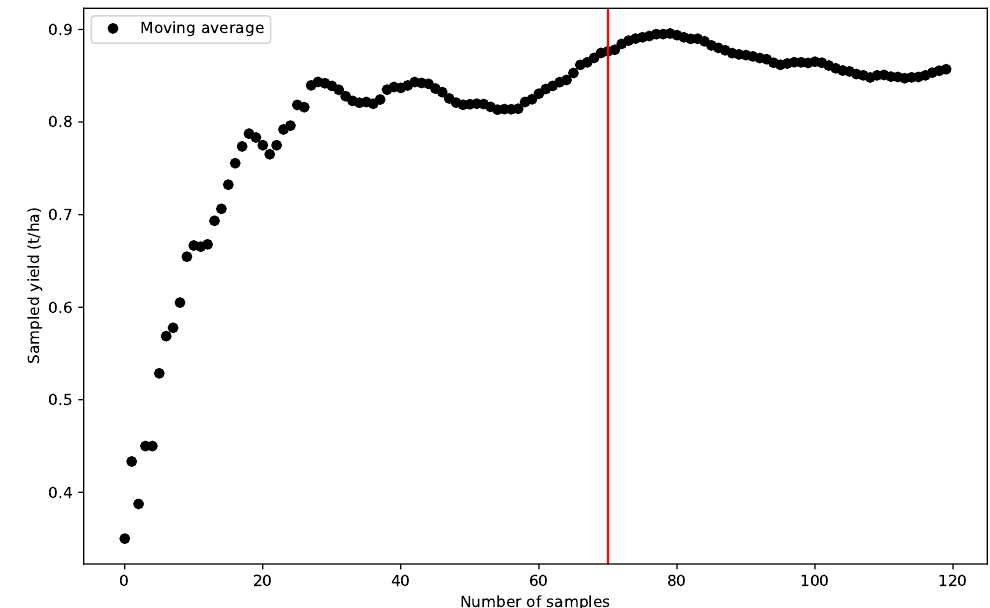
Figure 4. Plot of the moving average of 120 individual pasture yield quadrats across an area adjacent to the Esk field site. The red line indicates number of quadrats to be sampled across each field plot throughout the growing period.